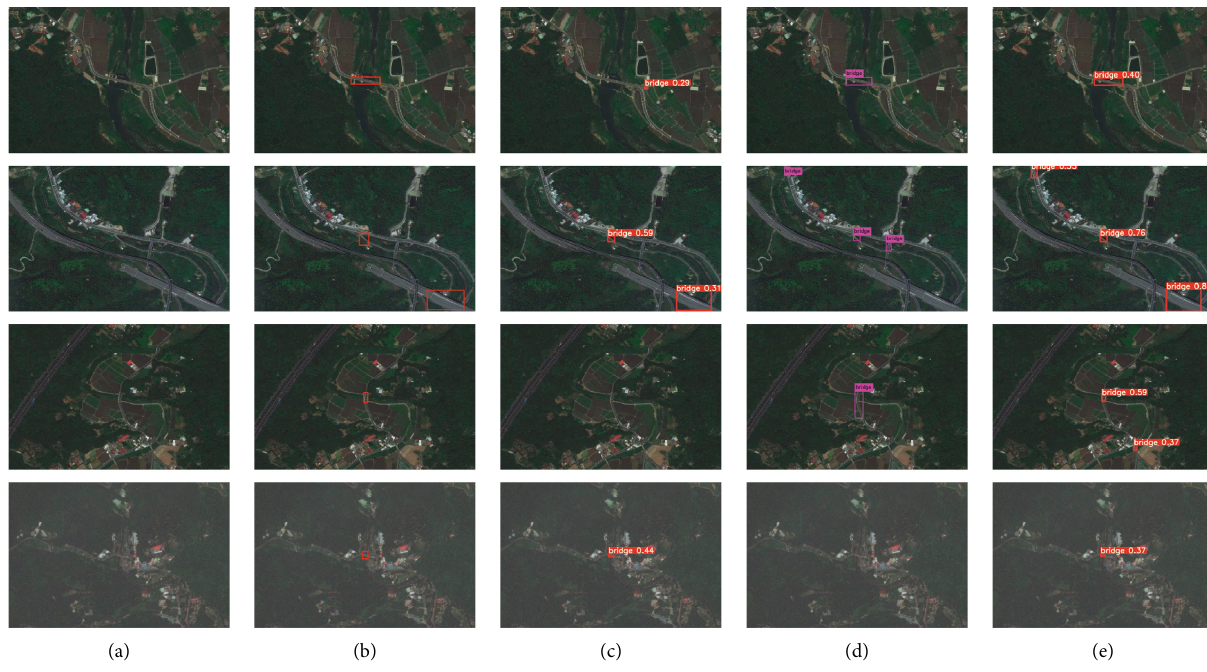
Figure 15: The comparisons of four different detection methods (i.e., (b) Faster R-CNN, (c) YOLOv3, (d) YOLOv4, and (e) YOLOv5s) for bridge detection under realistic low-light imaging scenarios. (a) Original. (b) Faster R-CNN, (c) YOLOv3, (d) YOLOv4. (e) YOLOv5s.